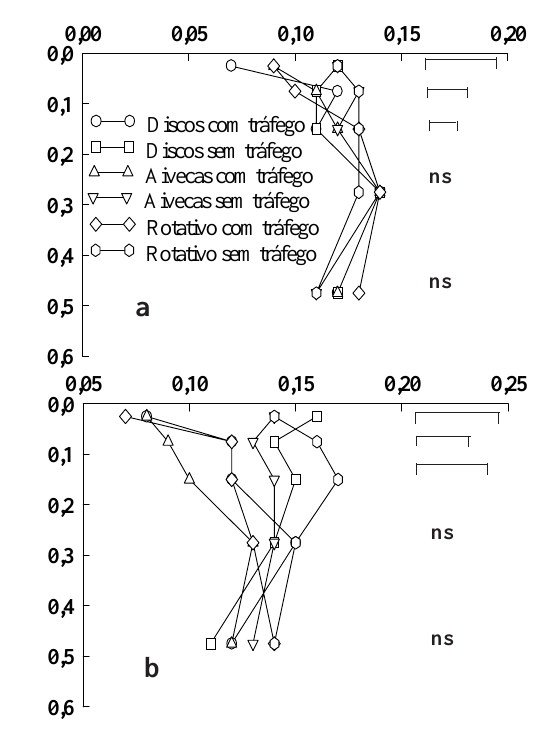
Figura 4. Conteúdo de água disponível entre os potenciais de -0,006 e -0,5 MPa das amostragens realizadas em março de 1990 (a) e maio de 1991 (b). (As barras horizontais indicam as diferenças mínimas significativas entre os tratamentos obtidas pelo teste de Tukey (p < 0,01) e ns indica ausência de diferenças entre os